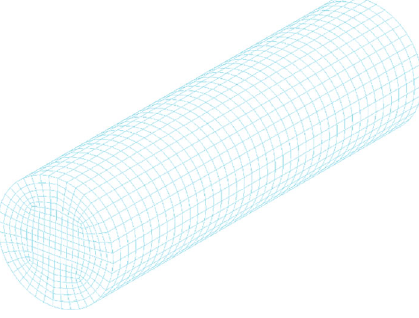
Figure 1: Finite element model of the